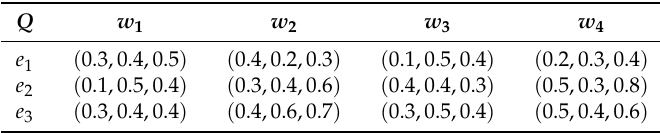
Table 1. Neutrosophic soft relation Q